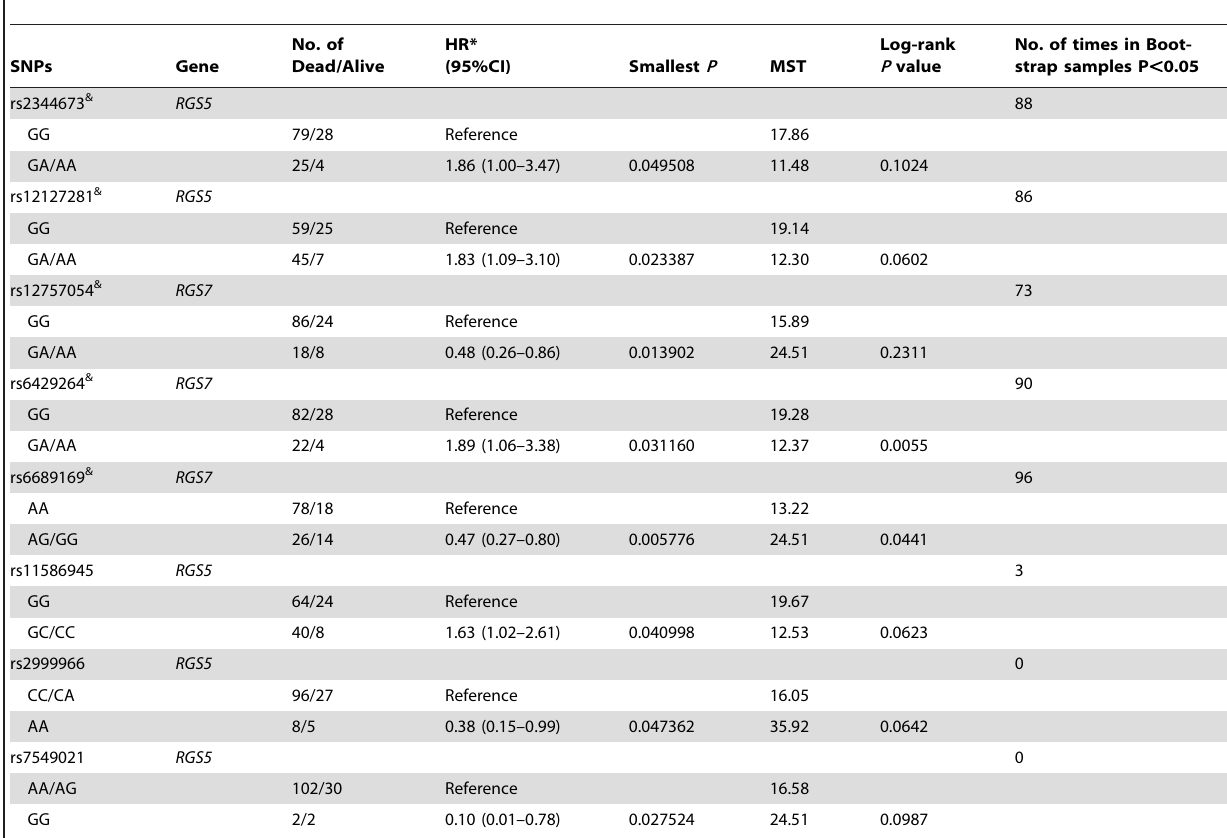
Table 4. Stratified analysis by treatment modality: